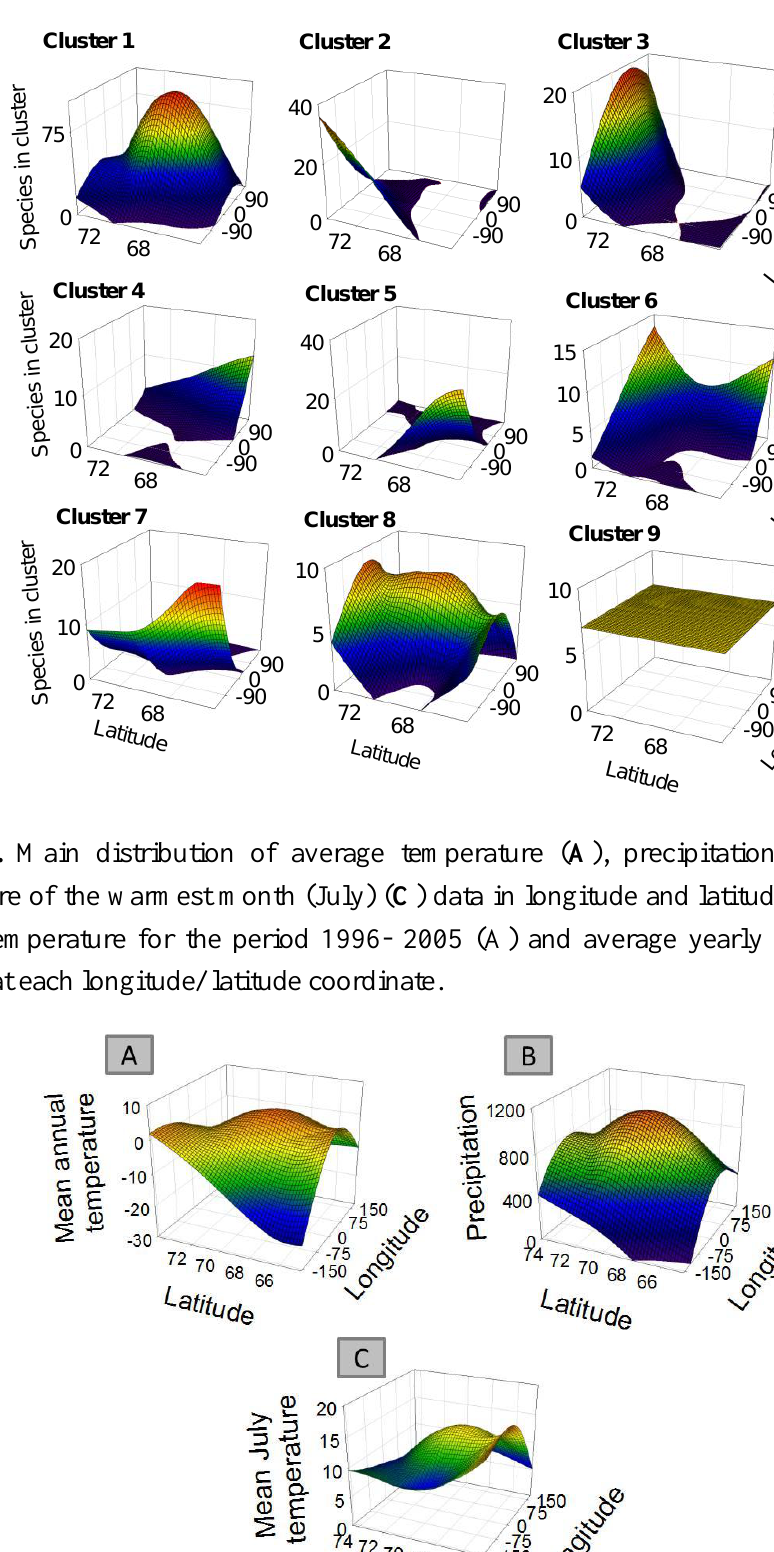
Figure 3. Main distribution of the species in a longitude and latitude axis system for each species cluster, as number of species of the cluster present at each longitude/latitude coordinate.